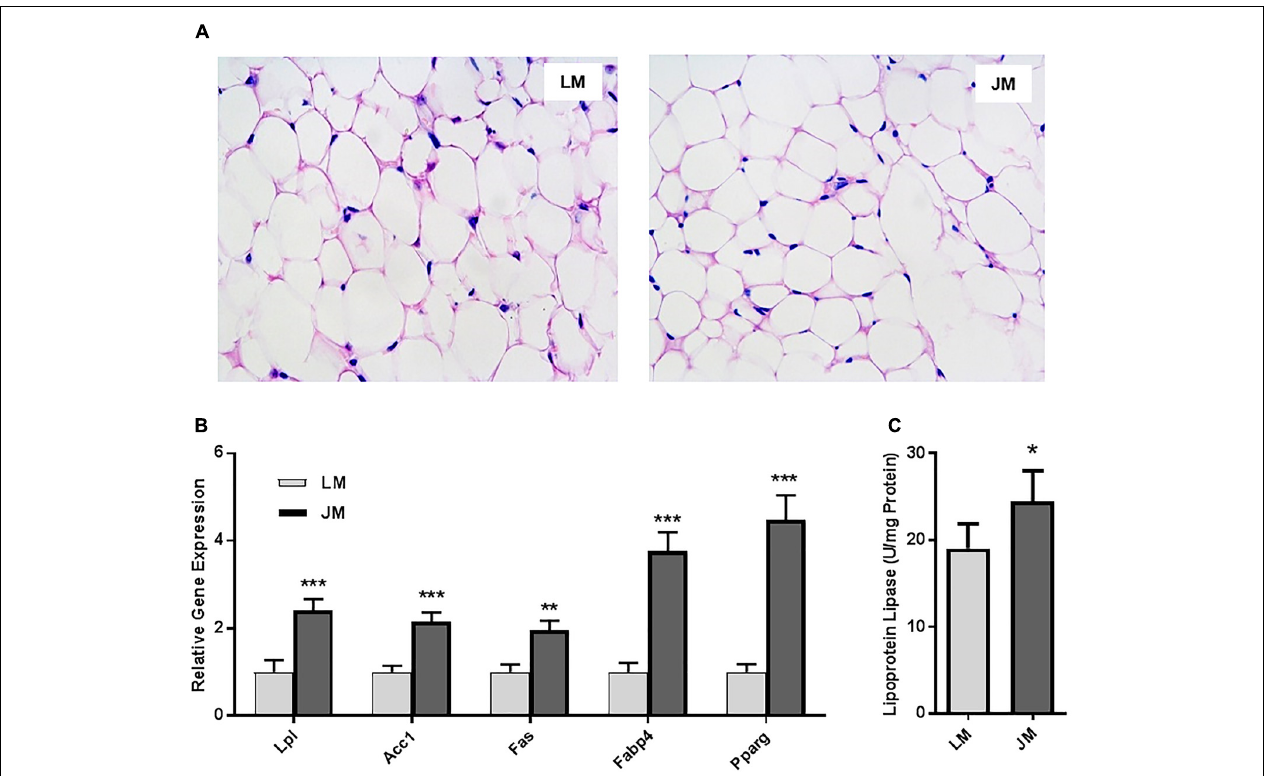
FIGURE 9 | Fat deposition and lipogenesis in the abdominal fat tissue of mouse recipients. (A) Representative pictures of the abdominal fat sections stained with hematoxylin and eosin (magnification: 200 × ). (B) Relative expression levels of several major lipogenic genes in the abdominal fat of mice transplanted with Landrace and Jinhua pig microbiota. (C) The lipoprotein lipase activity in the abdominal fat of mouse recipients. The results were shown as means ± SEM of 12 mice. ∗ P < 0.05, ∗∗ P < 0.01, and ∗∗∗ P < 0.001 (by unpaired Student’s t -test). LM, mice receiving fecal microbiota from Landrace pigs; JM, mice receiving fecal microbiota from Jinhua pigs.